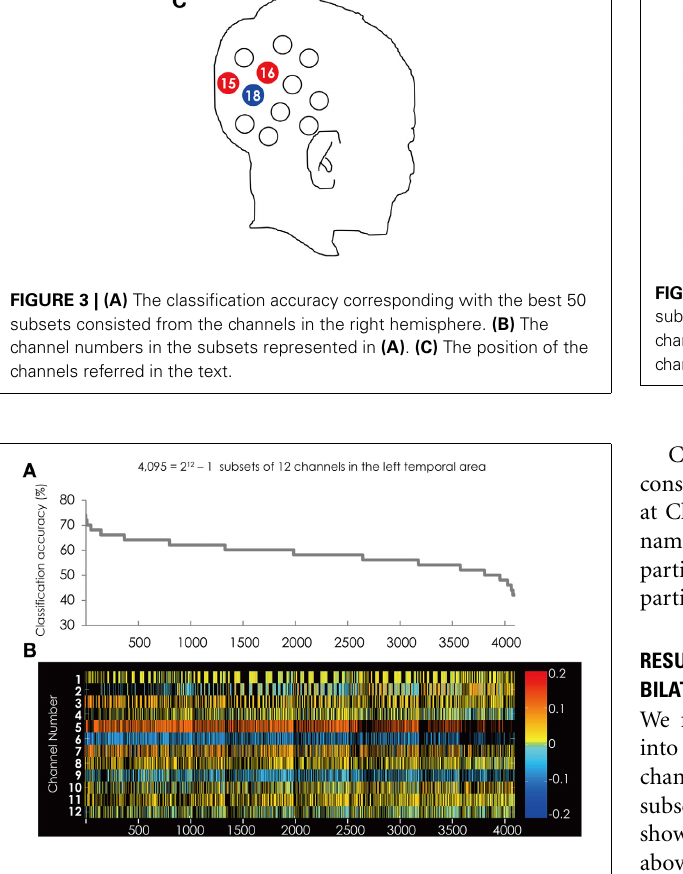
FIGURE 4 | (A) The classification accuracy corresponding with 4095 subsets consisted from the channels in the left hemisphere. (B) The channel numbers in the subsets represented in (A) .